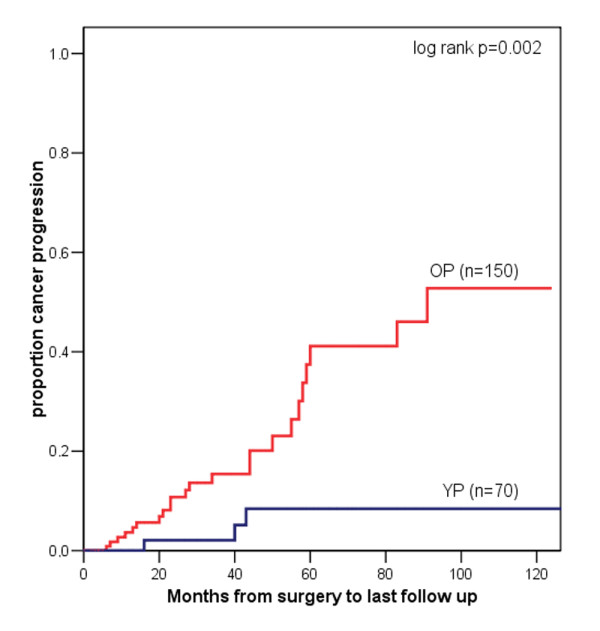
Kaplan-Meier analysis of cancer progression for YP (= blue line) vs. OP (= red line) with RCC.